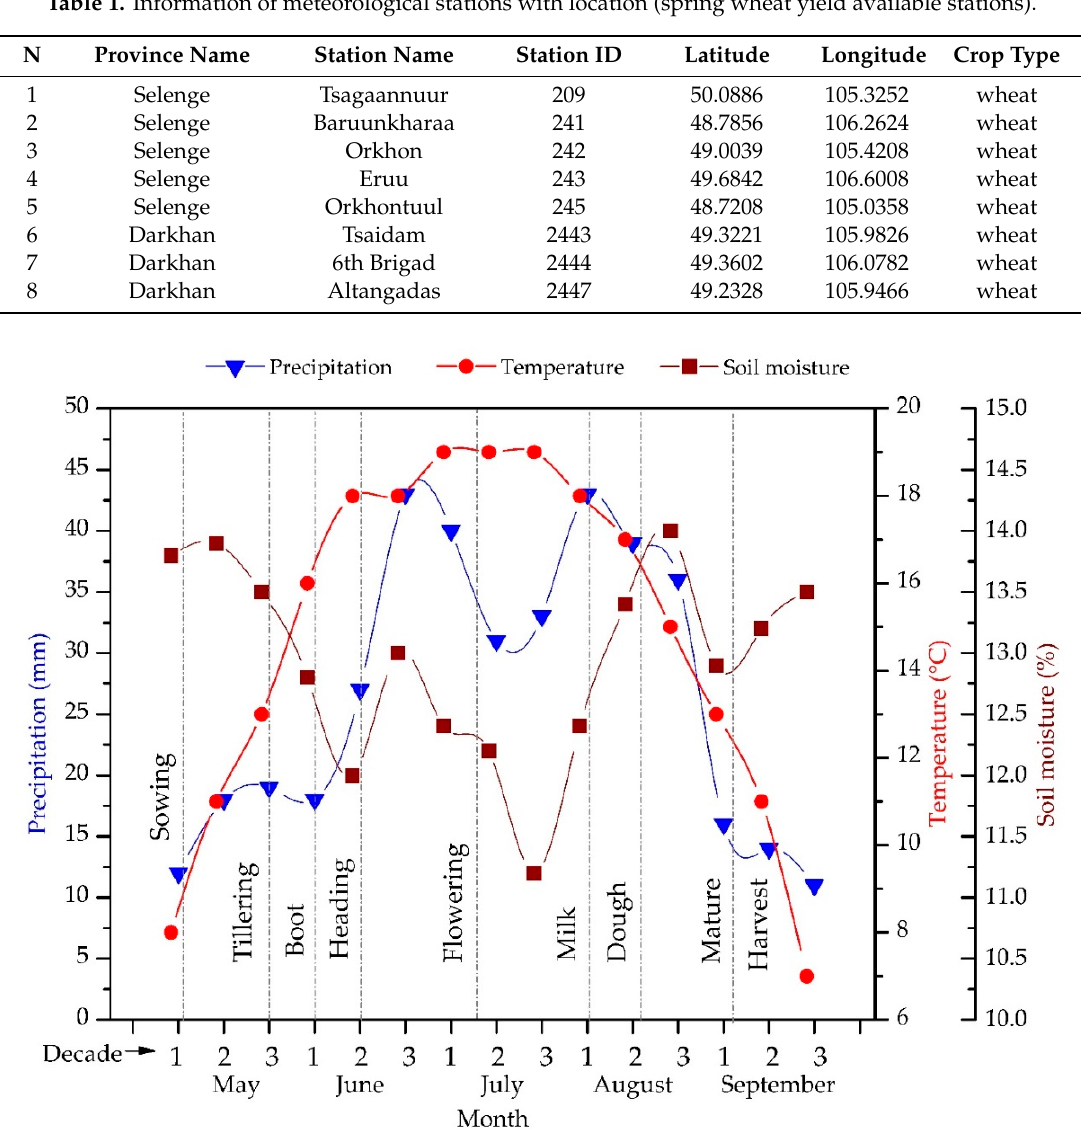
Table 1. Information of meteorological stations with location (spring wheat yield available stations).